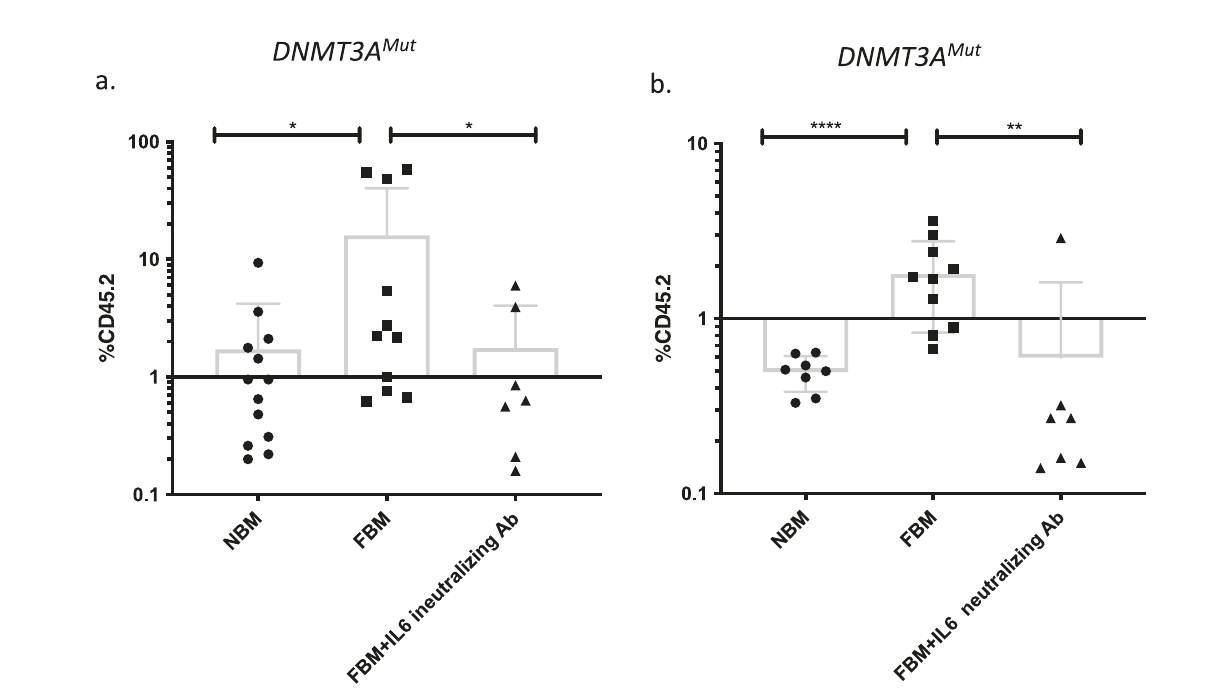
Fig. 6 | In vivo treatment with neutralizing IL-6 antibodies. a Signi fi cant engraftment decrease of DNMT3A Mut BM-derived cells in NSG mice following administration of neutralizing IL-6 Ab. In all, 6×10 6 DNMT3A Mut BM-derived cells were transplanted to normal bone marrow (NBM) ( n =13), and fatty bone marrow (FBM) ( n =11) and FBM NSG mice ( n =7) treated with neutralizing IL-6 Ab (Clone: MP5-20F3, Ultra-LEAF ™ Puri fi ed anti-mouse IL-6 Antibody, BioLegend